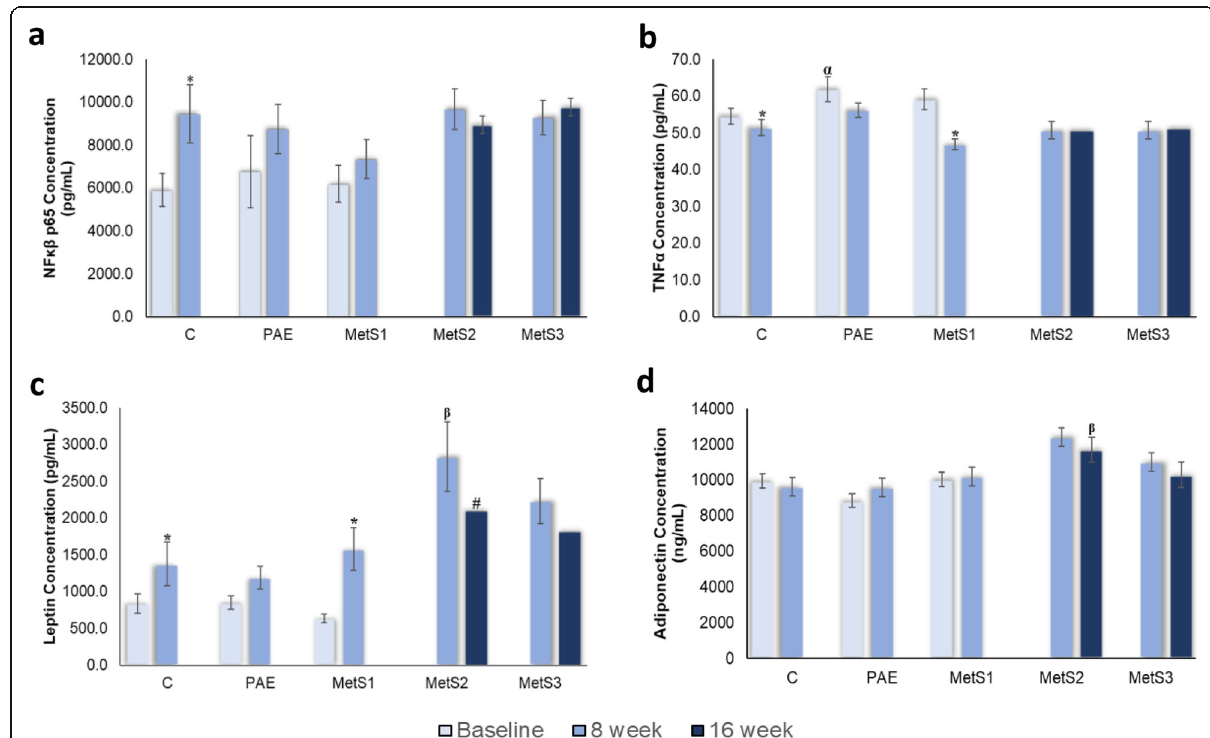
Fig. 5 Protein Expression of a NF κβ p65, b TNF α , c Leptin and d Adiponectin in C, PAE, MetS1, MetS2 and MetS3. n = 6. * p < 0.05 compared to 0th week. # p < 0.05 compared to 8th week. α p < 0.05 compared to MetS1. β p < 0.05 compared to